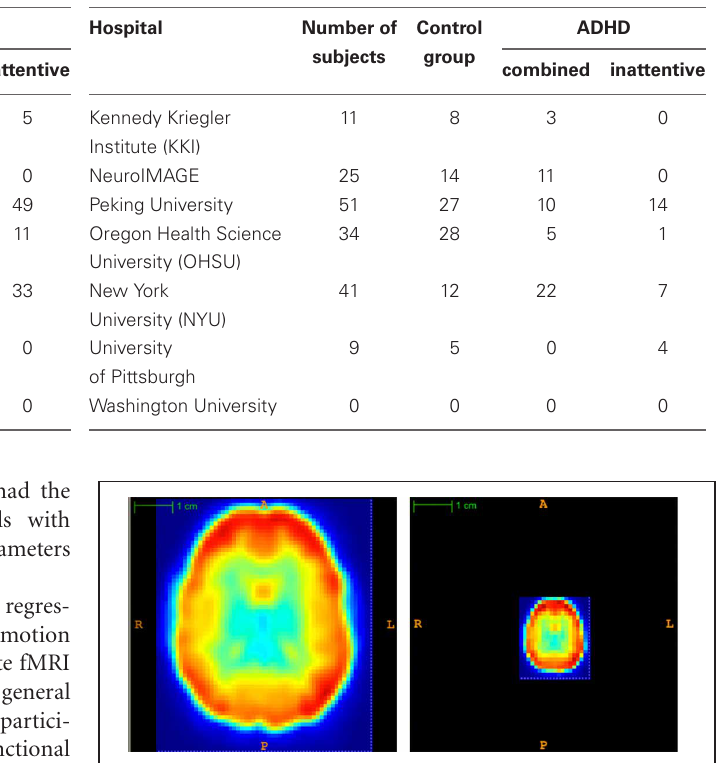
Table 1 | Distribution of ADHD patients and control subjects contained in the original (left) and holdout (right) datasets.